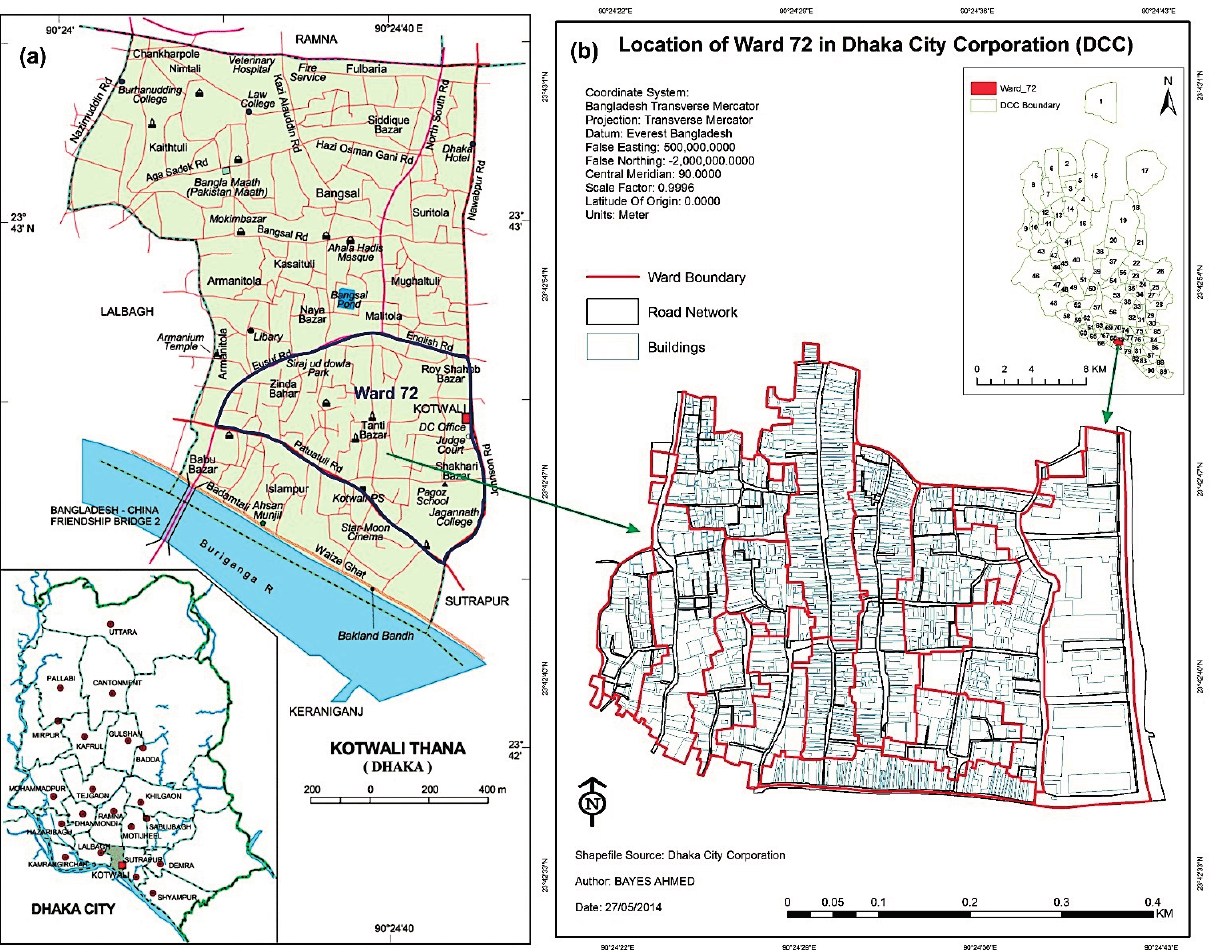
Figure 3. Location of ward 72 ( a ) in Kotwali thana and; ( b ) in DCC. Source: (a) Banglapedia , National Encyclopedia of Bangladesh,